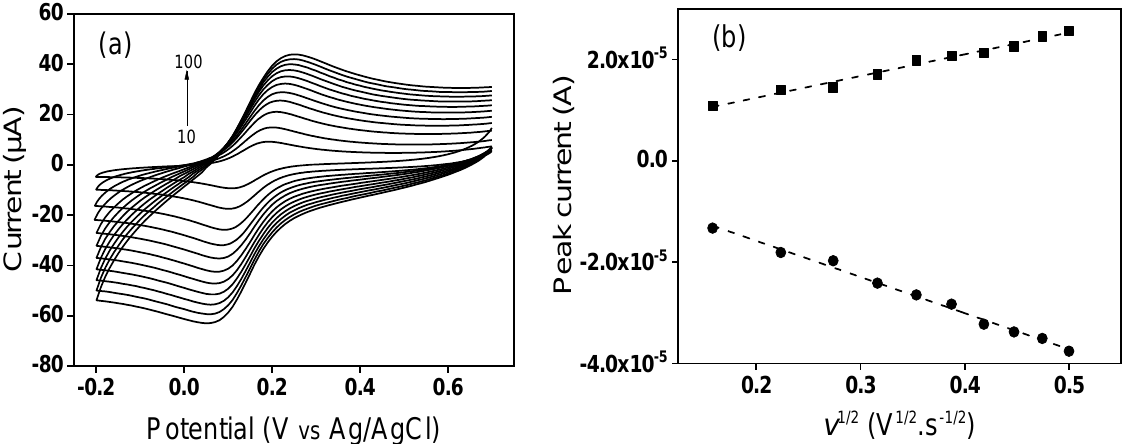
Figure 7. ( a ) Cyclic voltammograms at various scan rates (10 to 100 mV.s −1 ) recorded in 0.1 M KCl containing 1 mM [Fe(CN) 6 ] 3 − on bare GCE, and ( b ) linear plot of Ip (peak current) vs. v 1/2 .